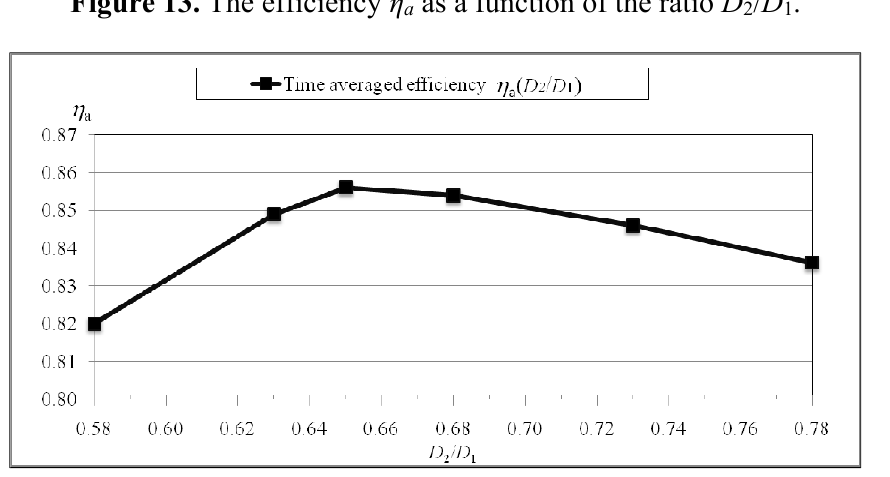
Figure 13. The efficiency η